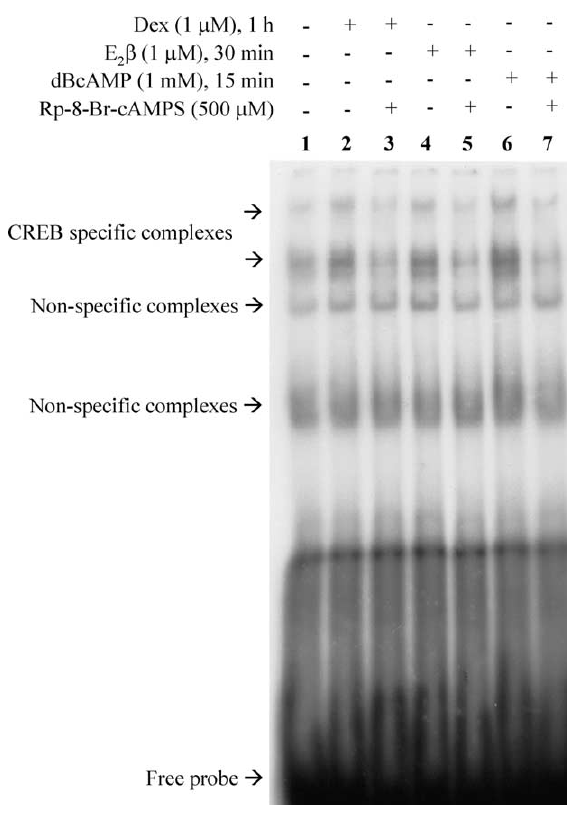
FIG. 4. Rp-8-Br-cAMPS inhibits Dex-induced, E 2 b -induced and dBcAMP-induced CREB activation in CCRF-CEM cells. The cells were incubated in the presence or in the absence (control, lane 1) of the cAMP antagonist Rp-8-Br-cAMPS (500 m M), for 1 h. Then, the cells were further incubated with Dex (1 m M), E 2 b (1 m M) or dBcAMP (1 mM) for l h, 30 min or 15 min, respectively. Nuclear extracts were subjected to EMSA analysis as described in Materials and methods. The results shown are representative of three independent